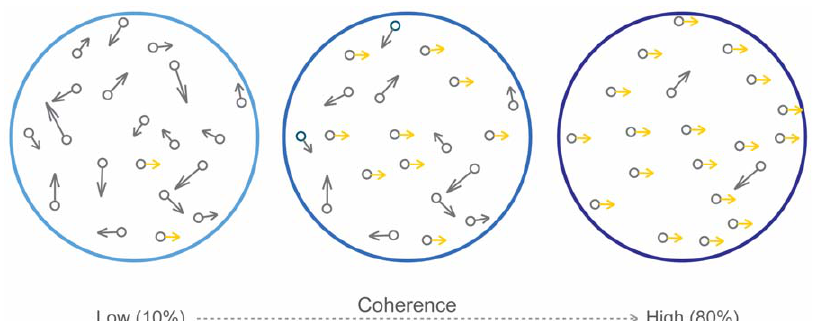
Figure 1. Coherent motion perception display. The coherent motion display contains a set of moving dots, a fixed proportion of which are moving in a coherent direction (e.g. 0 u in the figure above, in gold), while the rest are randomly replotted. When this proportion (‘‘coherence level’’) is high, task difficulty is low.